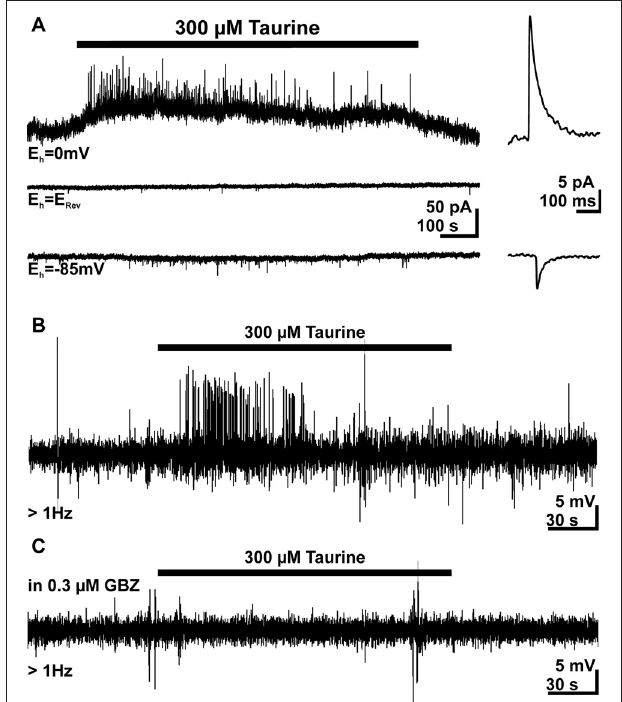
FIGURE 7 | Taurine induces Cl − -dependent, excitatory PSCs . (A) Current traces recorded at a holding potential ( E h ) of 0 mV (upper trace) and − 85 mV (bottom trace). For the middle trace E h was set exactly at the GABA reversal potential ( E Rev ), which was experimentally determined by focal GABA pulses. There experiments were performed with a low Cl − concentration in the pipette. Note that no taurine-induced increase in PSC frequency is visible if E h = E Rev and that the PSCs reverse their direction at this potential. Averaged PSCs are displayed at higher temporal resolution in the right panel. (B) Typical trace of a cell-attached recording from a pyramidal neuron. Bath application of 300 µ M taurine induced APs. (C) In the subsequent cell-attached recording from the same neuron as in B the taurine-induced APs are completely suppressed in the presence of 0.3 µ M gabazine